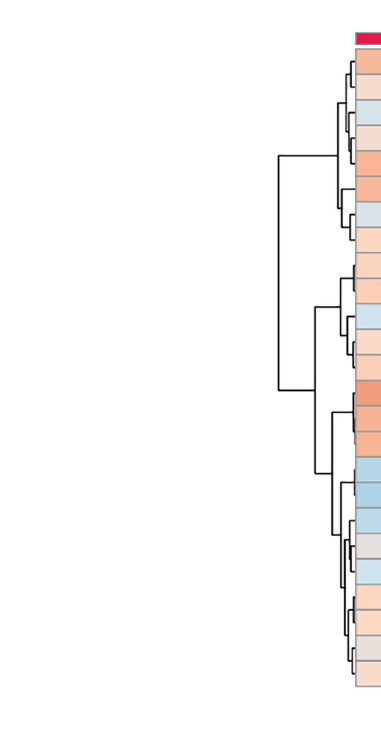
FIGURE 12 Heat map of top 25 metabolites among the fi ve rumen sacs. Heat map of the top 25 metabolites present among each of the fi ve rumen sacs. The darker the red equates to the greater relative abundance of the metabolite present within the rumen sac and the darker the blue equates to a lesser abundance of the metabolite present within the rumen sac. There was a difference in overall abundance of the metabolites in this heat map in the CVBS among the other four rumen sacs.